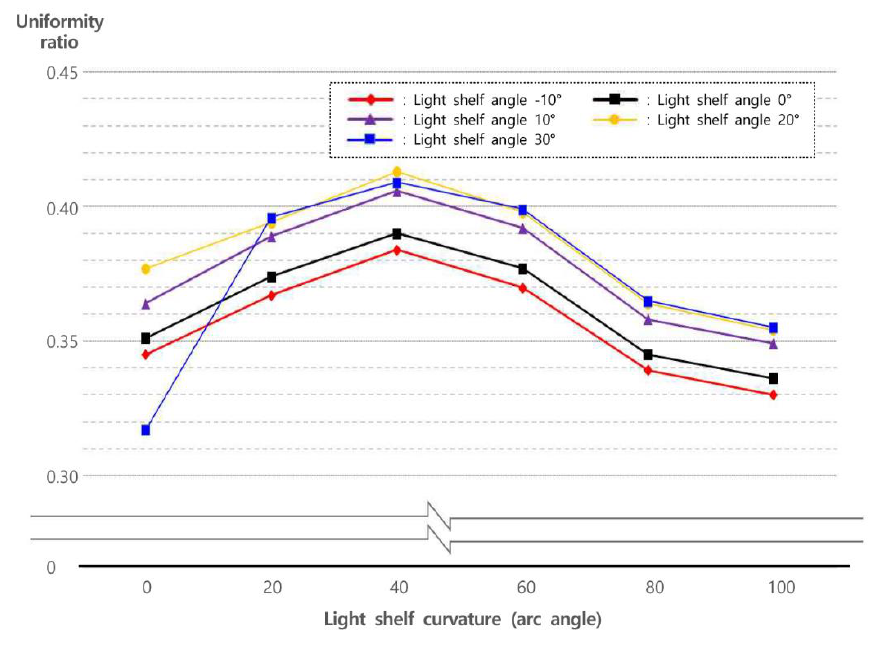
Figure 15. Uniformity ratio versus light shelf angle and arc angle during mid-season.